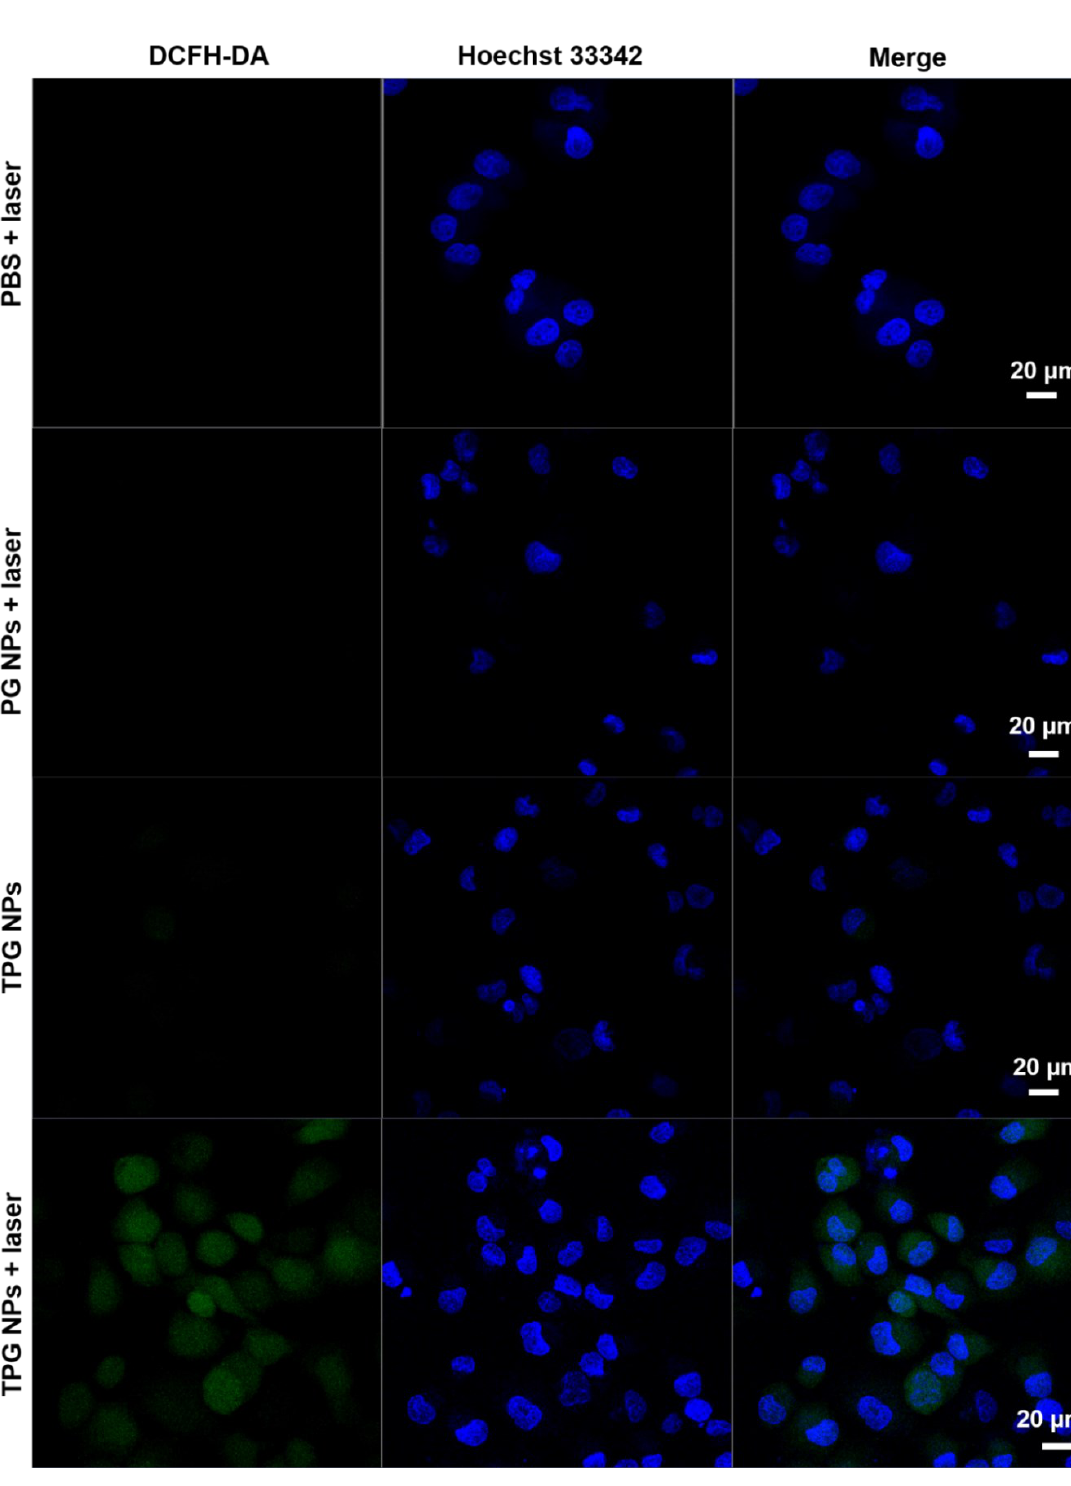
Figure 5. ROS generation in Panc-1 cells. Confocal microscopy images of PANC-1 cells after treatment with TPG NPs, PG NPs (NPs without THPP loading) and PBS for 24 h with/without laser irradiation and stained with DCFH-DA ( green ) and Hoechst ( blue ) (scale bar = 20 μm).